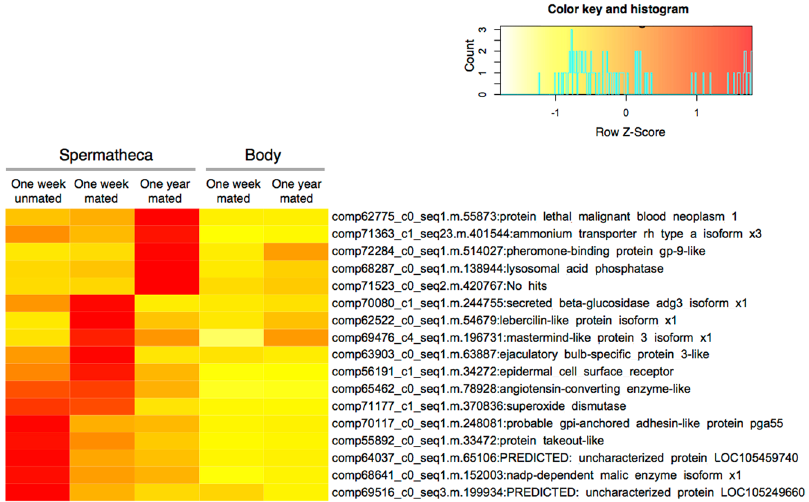
Figure 4. Heat map of selected genes that were regulated by mating status or sperm storage period in the spermathecae. Reads per million (RPM) values of the spermatheca and the body samples were calibrated to